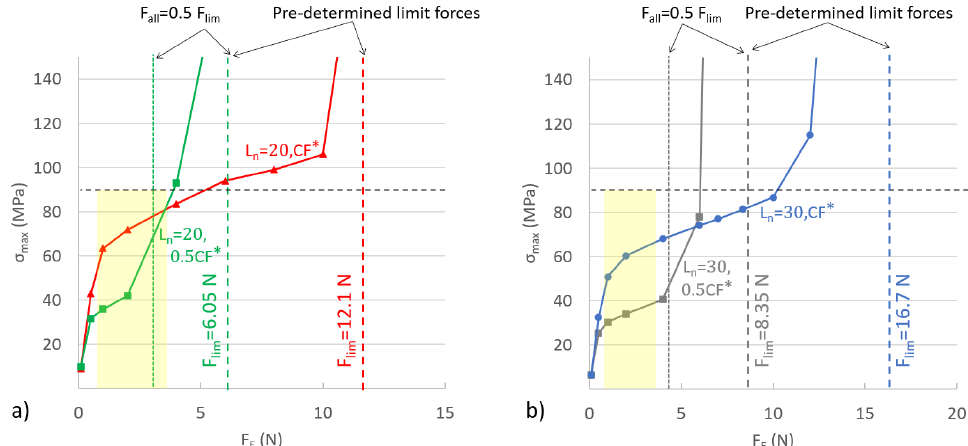
Figure 10. Blade A. Maximum “nominal” bending stress vs. F E for: ( a ) the shorter neck L n = 20 mm, full and half CF values, ( b ) the longer neck L n = 30 mm, full and half CF values. Shaded areas represent the maximum assumed span of the proof excitation force F E . The horizontal dashed line represents the allowable nominal bending stress σ a , bend .